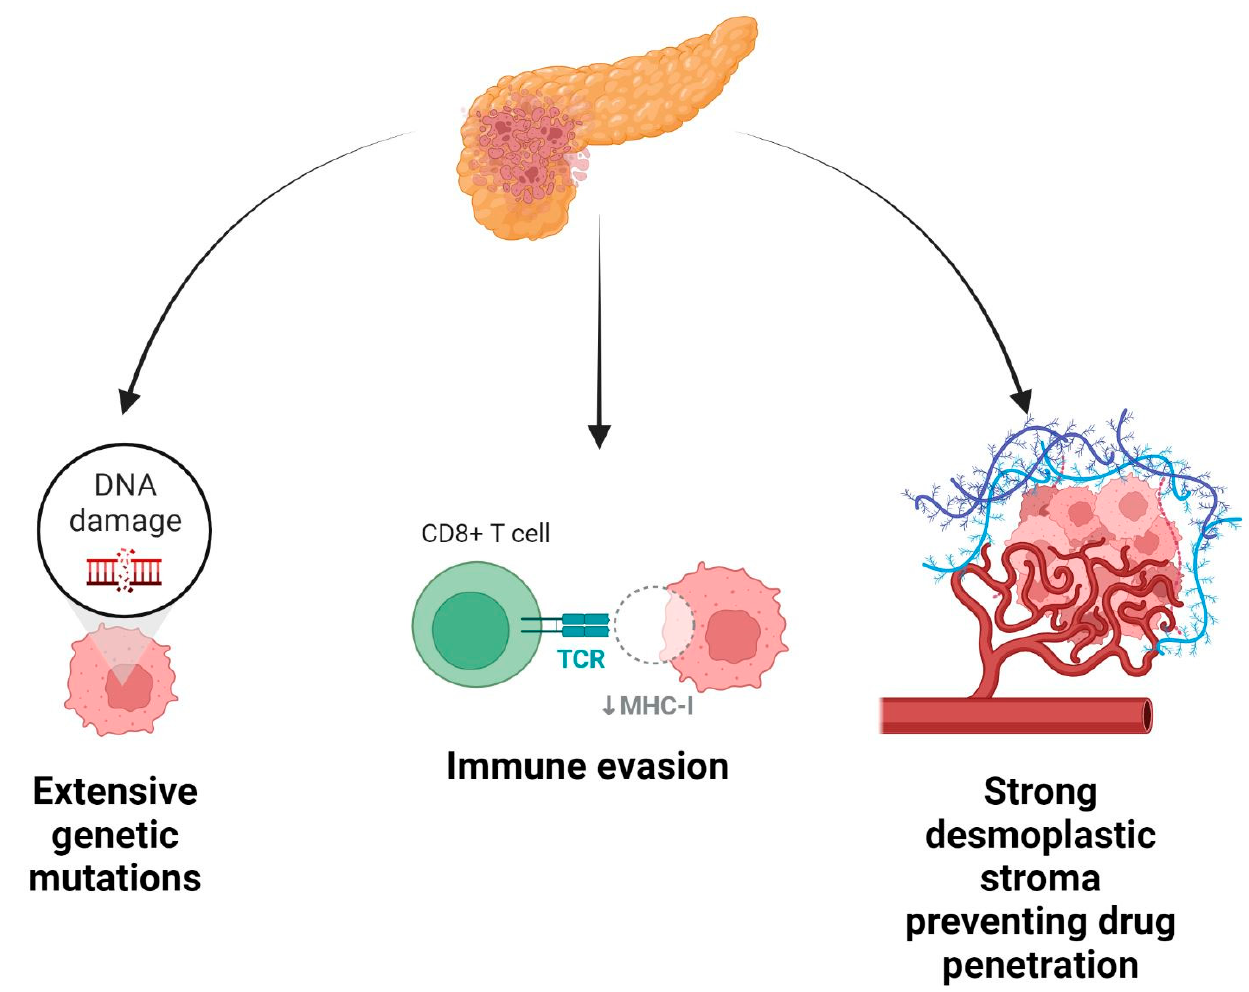
Figure 2. Mechanisms of drug resistance in pancreatic cancer.